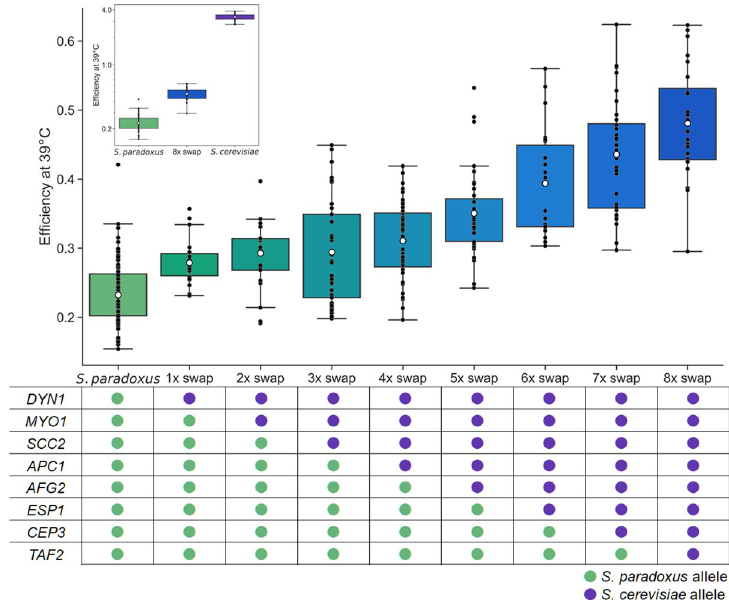
Fig 1. S . cerevisiae alleles of thermotolerance loci jointly improve growth at high temperature. In each plot, the y - axis reports growth efficiency at 39˚C, the cell density after a 24-hour incubation as a difference from the starting density. In the main plot, each column reports data from a transgenic S . paradoxus strain harboring S . cerevisiae alleles of the indicated thermotolerance loci, or the wild-type S . paradoxus progenitor. At bottom, each cell reports the genotype at the indicated locus in the indicated strain. The inset shows purebred wild-types and the S . paradoxus strain harboring all eight thermotolerance loci from S . cerevisiae (8x swap); the y -axis is log-scaled. Black points report individual biological replicates and white dots report means. Boxes span the interquartile range. Whiskers are 1.5 times the interquartile range. Statistical analyses are reported in S1A Table.